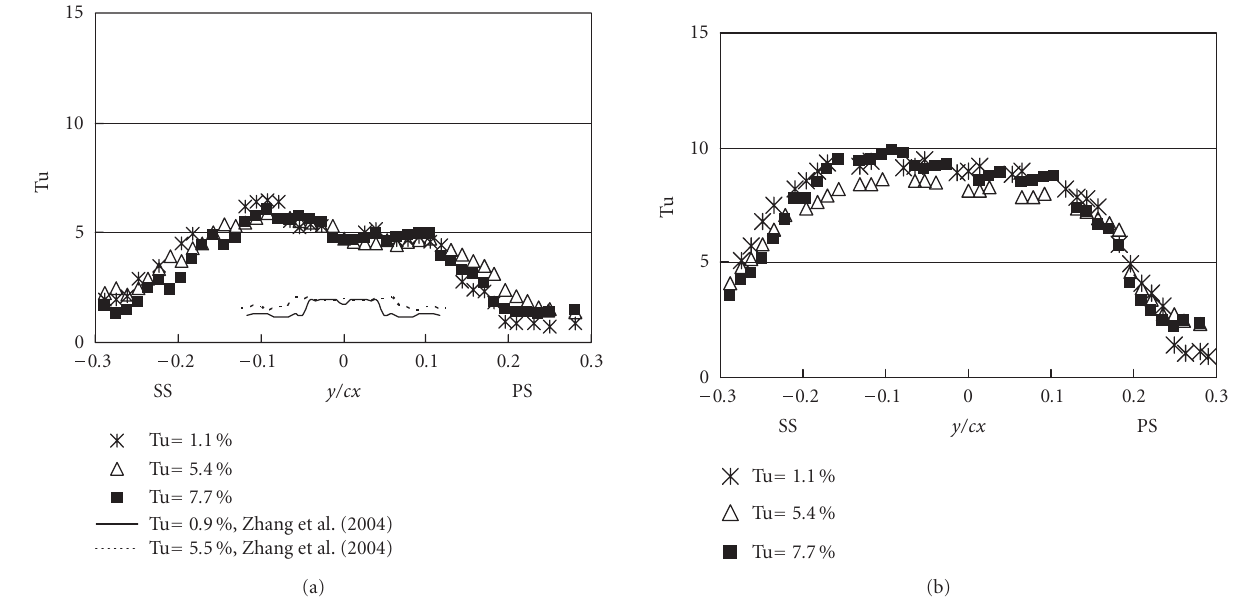
Figure 7: Profiles of turbulence intensity across the wakes measured one axial chord length downstream of the cambered airfoils with di ff erent inlet turbulence intensity levels. (a) Smooth airfoil, ks/cx = 0. (b) Airfoil with big-sized roughness, ks/cx = 0 . 00258.